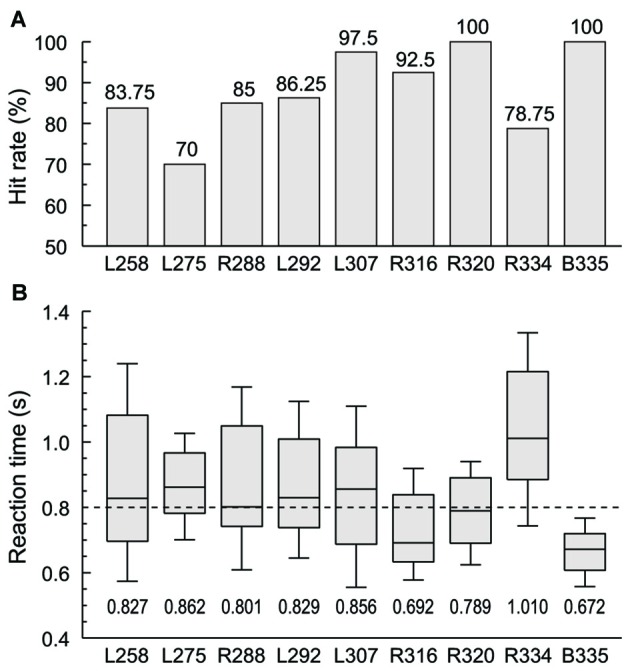
Subjects’ behavioral performance in the semantic categorization tasks. (A) Hit rates (% correctly detected target stimuli) for each of the nine subjects. (B) Reaction times (RTs). Box-and-whiskers plots depict median values and 10th, 25th, 75th and 90th percentiles; median values are shown for each subject underneath the plots. Dashed line corresponds to the grand median value (800 ms). Behavioral data from the two semantic categorization tasks (animals and numbers target category) were combined in each subject.